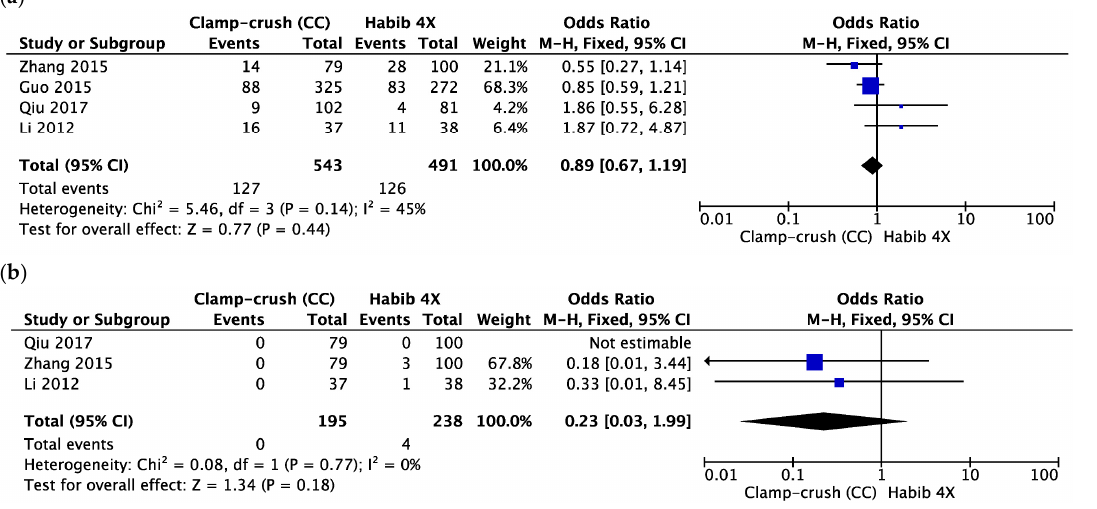
Figure 5. Forest plot representing ( a ) total morbidity and ( b ) 30-day mortality during liver resection comparing the control group (clamp-crush) with the study group (Habib™-4X). Squares’ size depicts effects while comparing the weight of the study in the meta-analysis. The diamond shows no favour towards any study group following analysis. The 95 percent confidence interval is represented as horizontal bars.